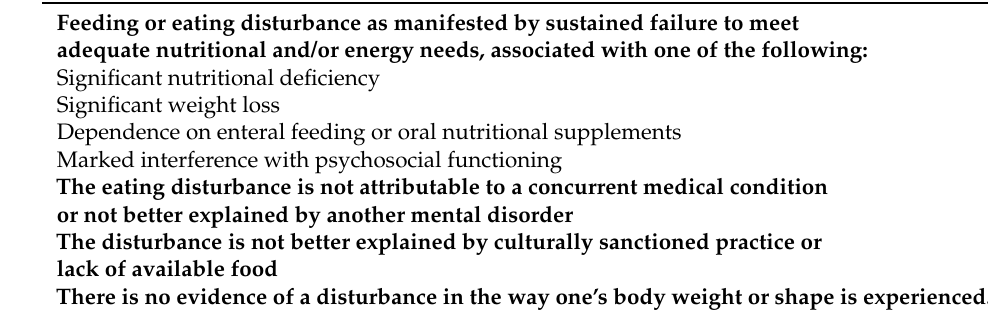
Table 4. Diagnostic criteria for avoidant/restrictive food intake disorder (ARFID)